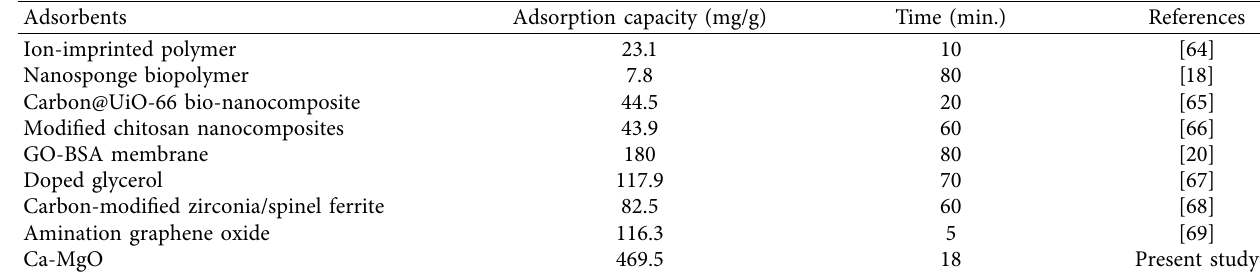
Table 3: Adsorption capability of various cited sorbents for the Co (II) ions removal. Adsorbents Adsorption capacity (mg/g) Time (min.)